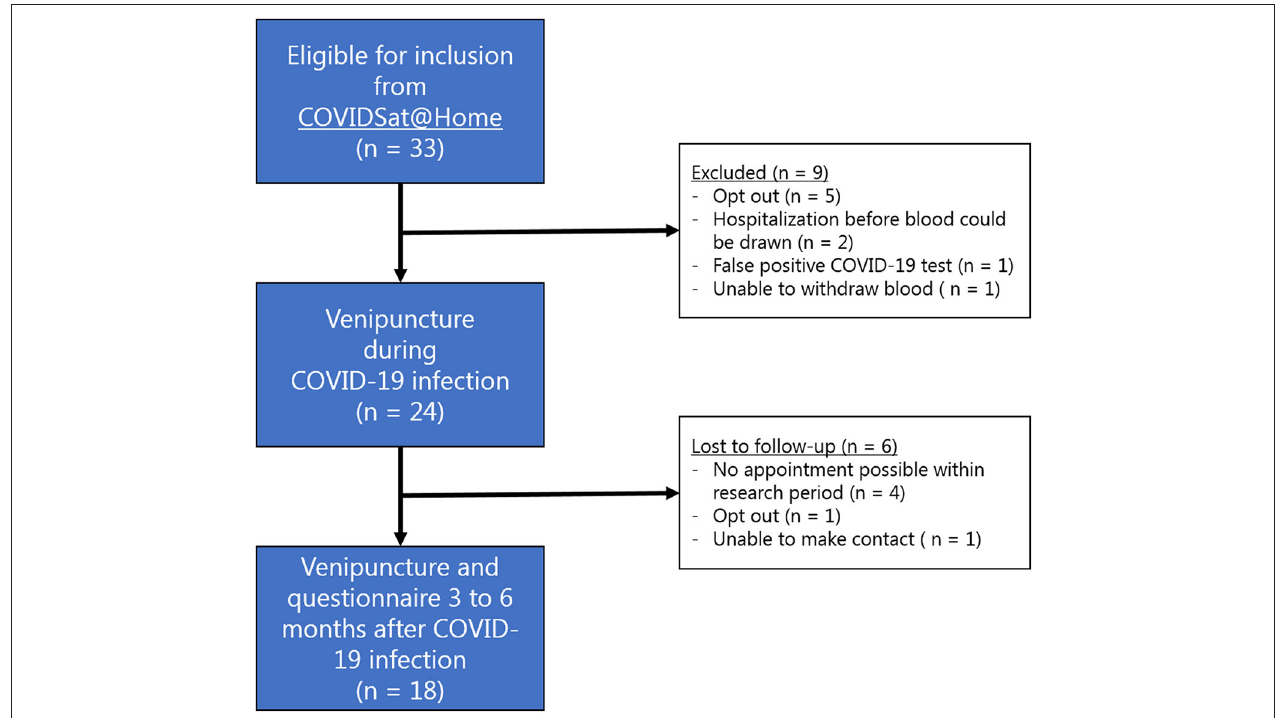
FIGURE 1 | Flowchart depicting the inclusion of patients for this